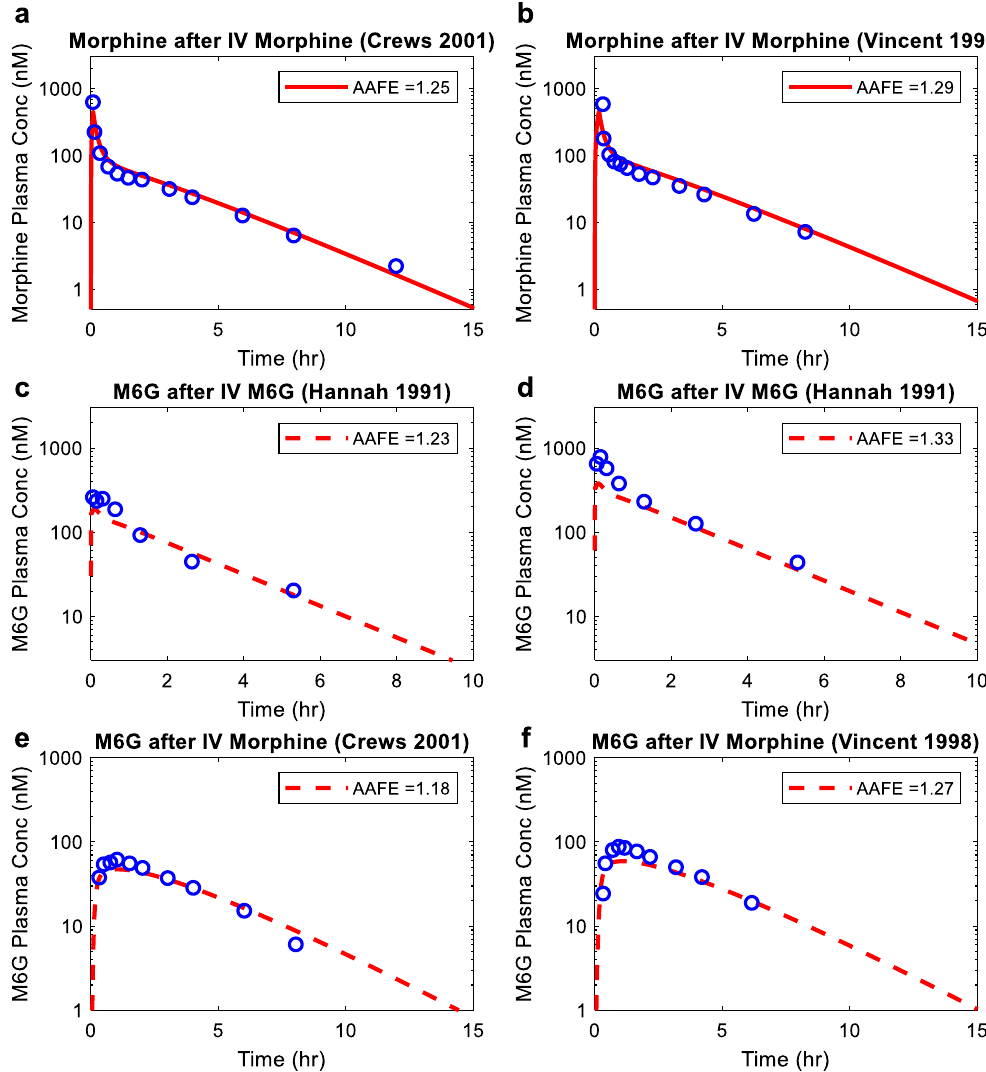
Figure 4. Simulation of morphine and M6G plasma concentration–time profiles in healthy subjects. Plasma morphine concentration–time profile was simulated after intravenous dosing of morphine (shown in red solid curves) in comparison to the observed data in healthy subjects from two independent studies 19,22 (panel a and b ). Plasma M6G concentration–time profile was simulated after intravenous dosing of M6G (shown in red dashed curves) in comparison to the observed data in healthy subjects from two different doses: 30 µg/kg (panel c ) and 60 µg/kg 23 (panel d ). Plasma M6G concentration–time profile was simulated as a metabolite (shown in red dashed curves) after intravenous dosing of morphine in comparison to the observed data in healthy subjects from two independent studies (panel e and f ) 19,22 . All simulation results are shown in red, and all observed data are shown in blue open circles. The calculated absolute average fold error value for each panel is shown in the